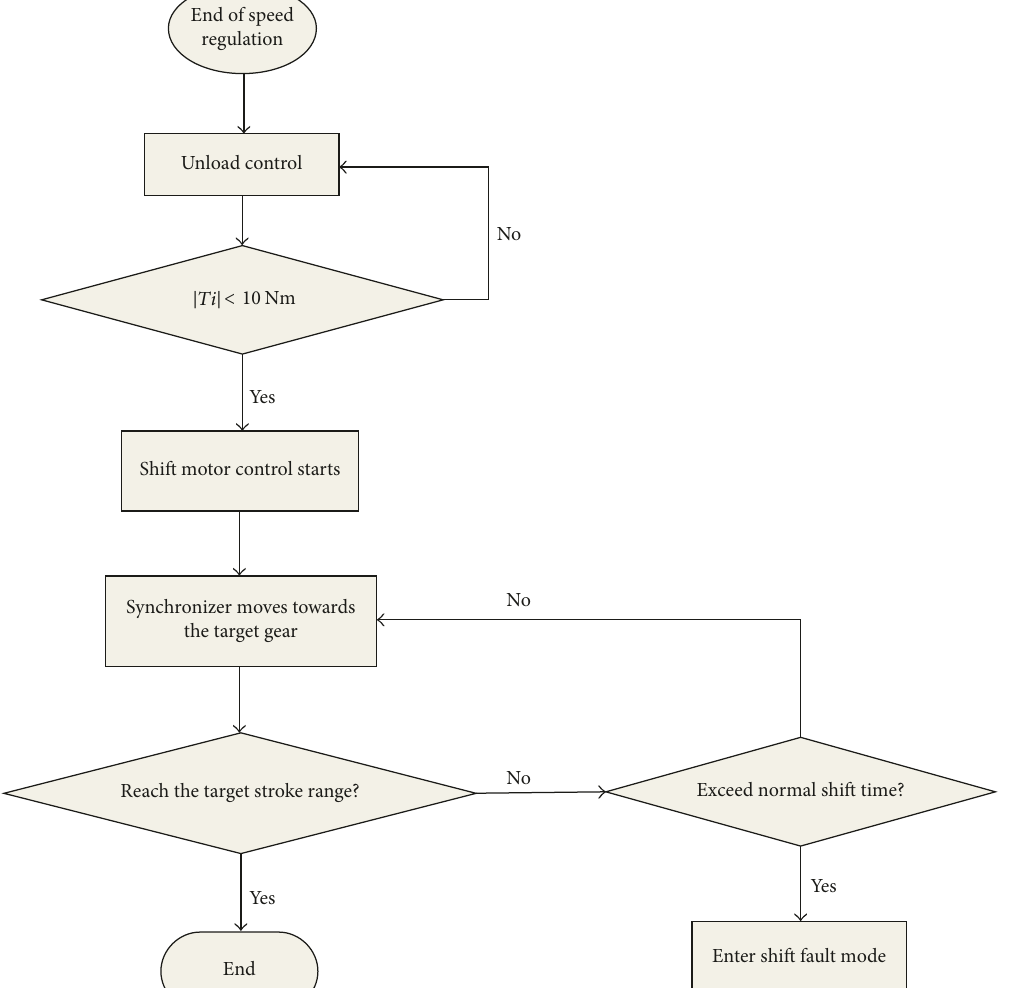
Figure 8: The synchronization phase’s flow chart.